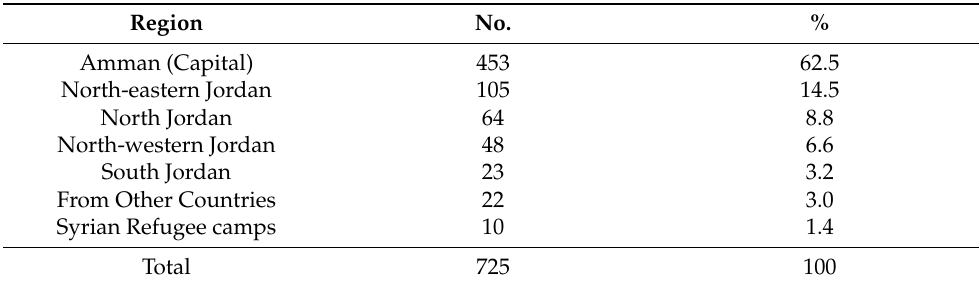
Table 1. Geographical distribution of service users.